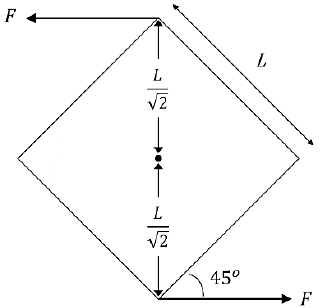
Fig. 2 Definition sketch for setup of torque